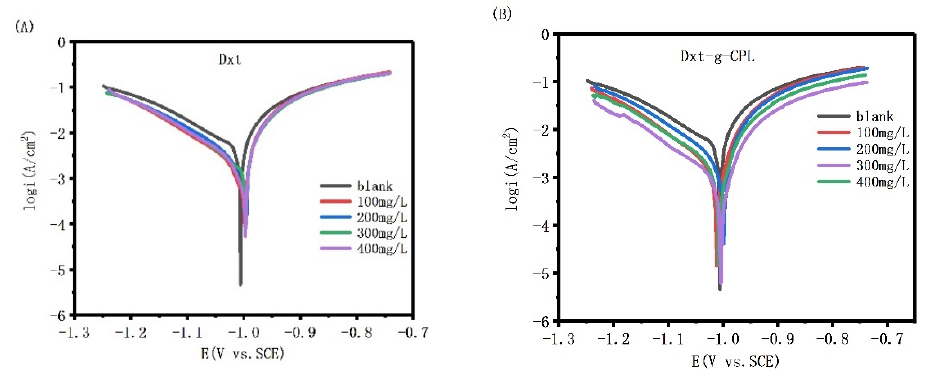
Figure 8. Potential polarization curves of J55 steel in 1 M HCl solution with different concentrations